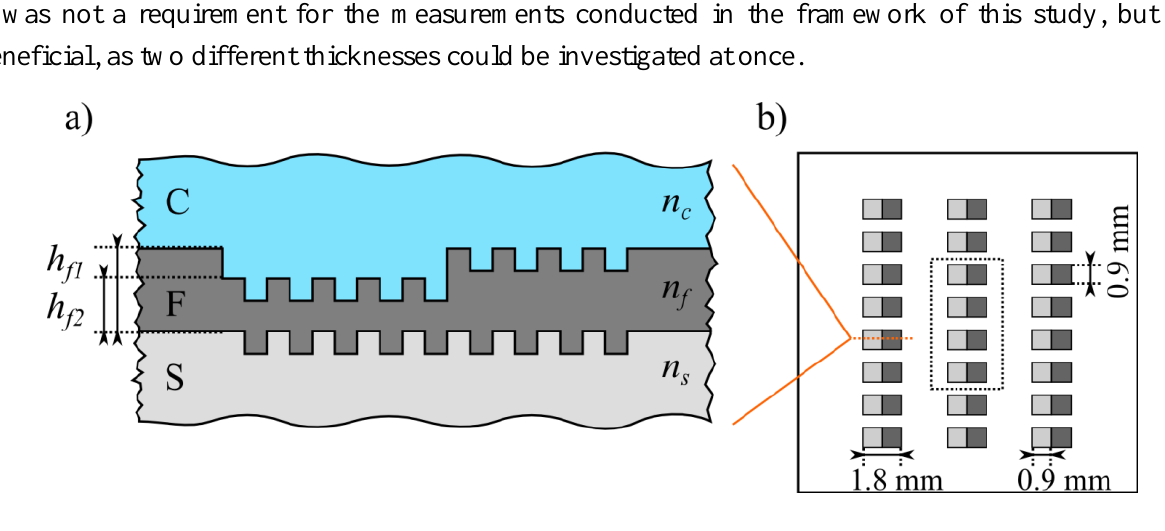
Figure 2. Schematic drawing of the investigated waveguide grating chips. ( a ) Cross section (not to scale); ( b ) Top view: Chip with 24 gratings with waveguide thickness h f 1 and h f 2 , respectively, whereas the central eight gratings (four of each height) have been considered per measurement per chip.